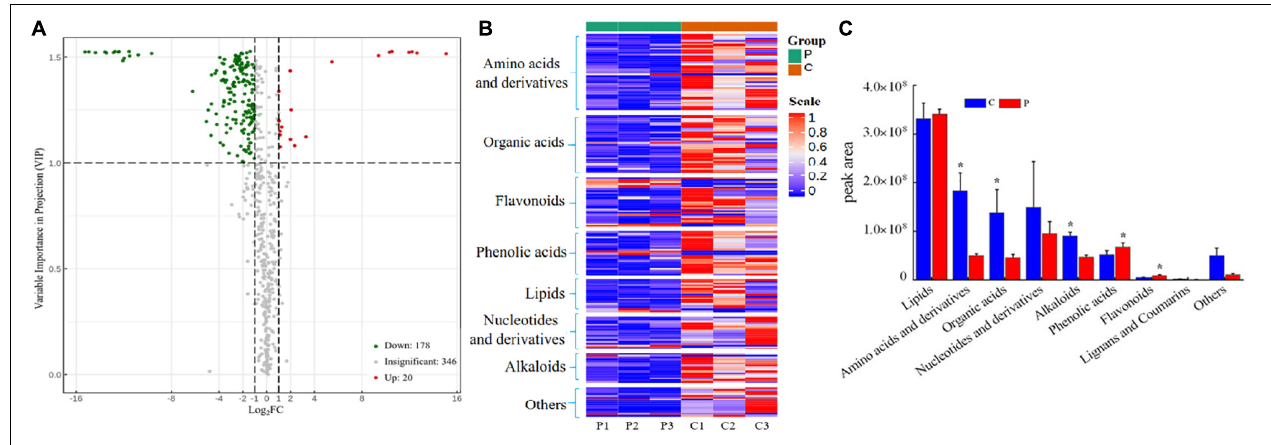
FIGURE 5 | (A) Volcano plot of differential expression of metabolites between the two treatments. VIP > 1 indicates that metabolite expression is significantly different. (B) Heatmap of significantly differential substances in root exudates of control-treated and pathogen-inoculated tea seedlings. (C) Cumulative peak area of compound categories. “C” represents control treatment, “P” represents pathogen infection treatment. Data are means ± SDs of three replicates. * p < 0.05.